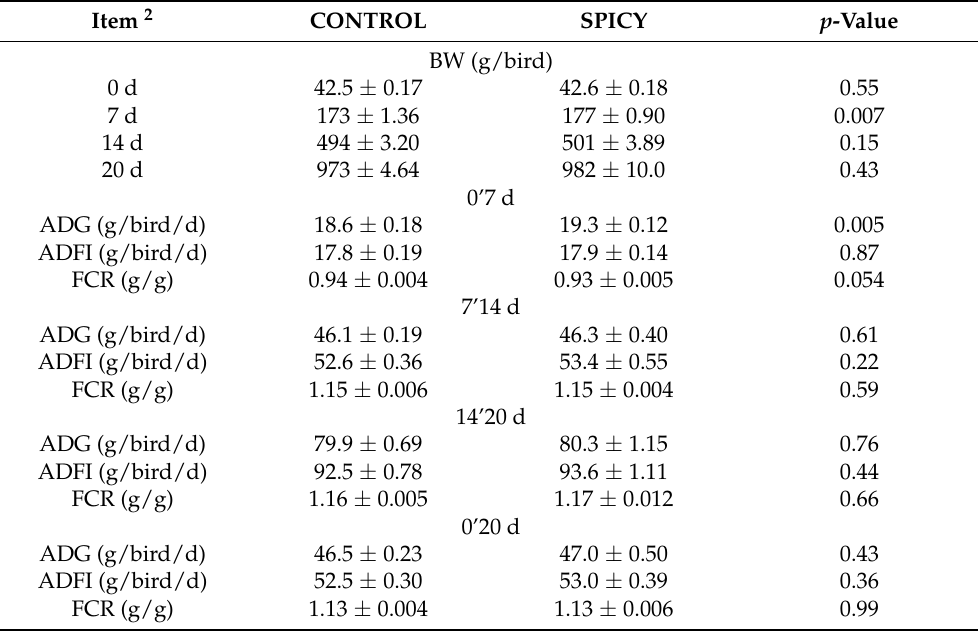
Table 3. Effect of experimental diets on broiler chicken growth performance from 0 to 20 d of age 1 .